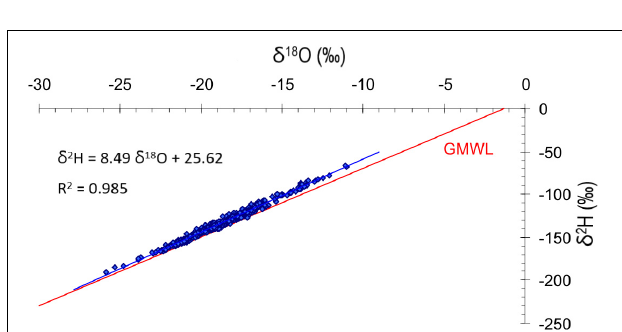
FIGURE 10 | Local (blue) and global (red) meteoric water line calculated from the Guanaco ice